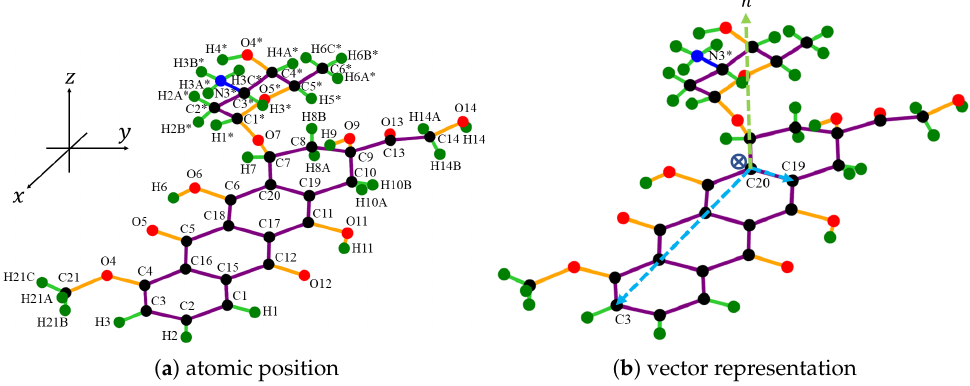
Figure 1. Discrete structure of DOXH where ( a ) indicates each atomic position and its reference number and ( b ) shows three vectors on the carbon ring plane with a center of mass near C 20